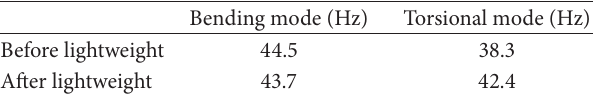
Table 8: The mode simulation of E-REV before and after light- weighting the main parts.